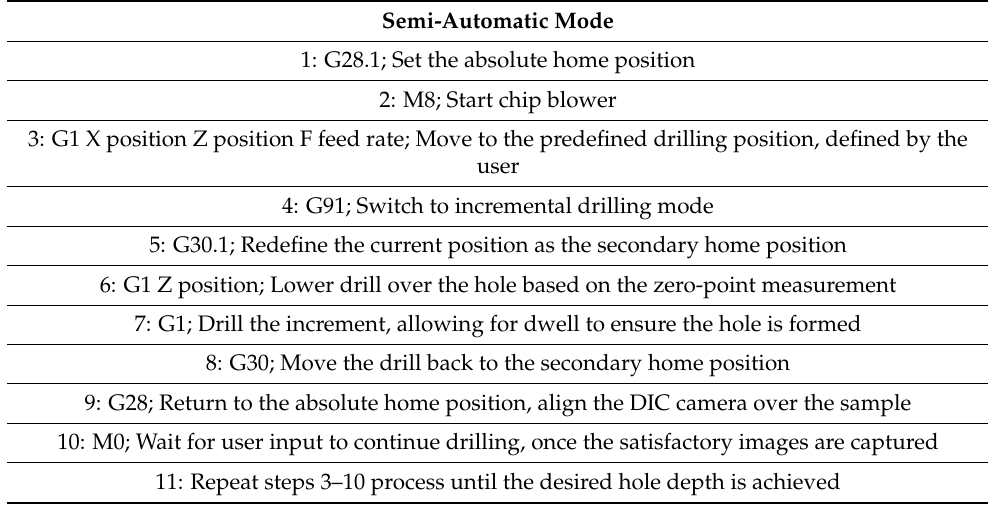
Table 3. Measurement cycle for the semi-automatic operation of the